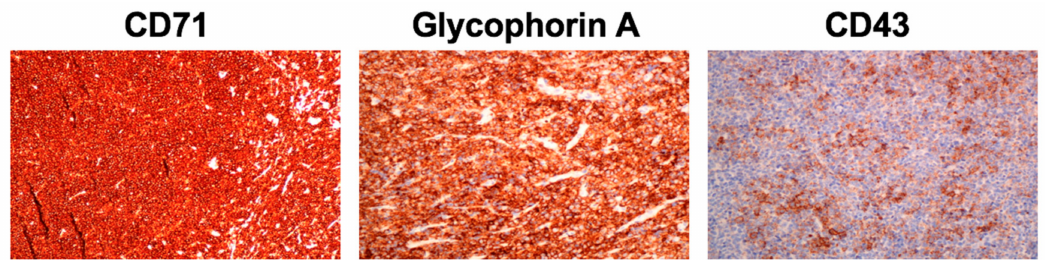
Figure 3. Periorbital biopsy. Diffuse infiltrate of medium-sized cells with intense positivity to CD71 and glycophorin A as well as partial expression of